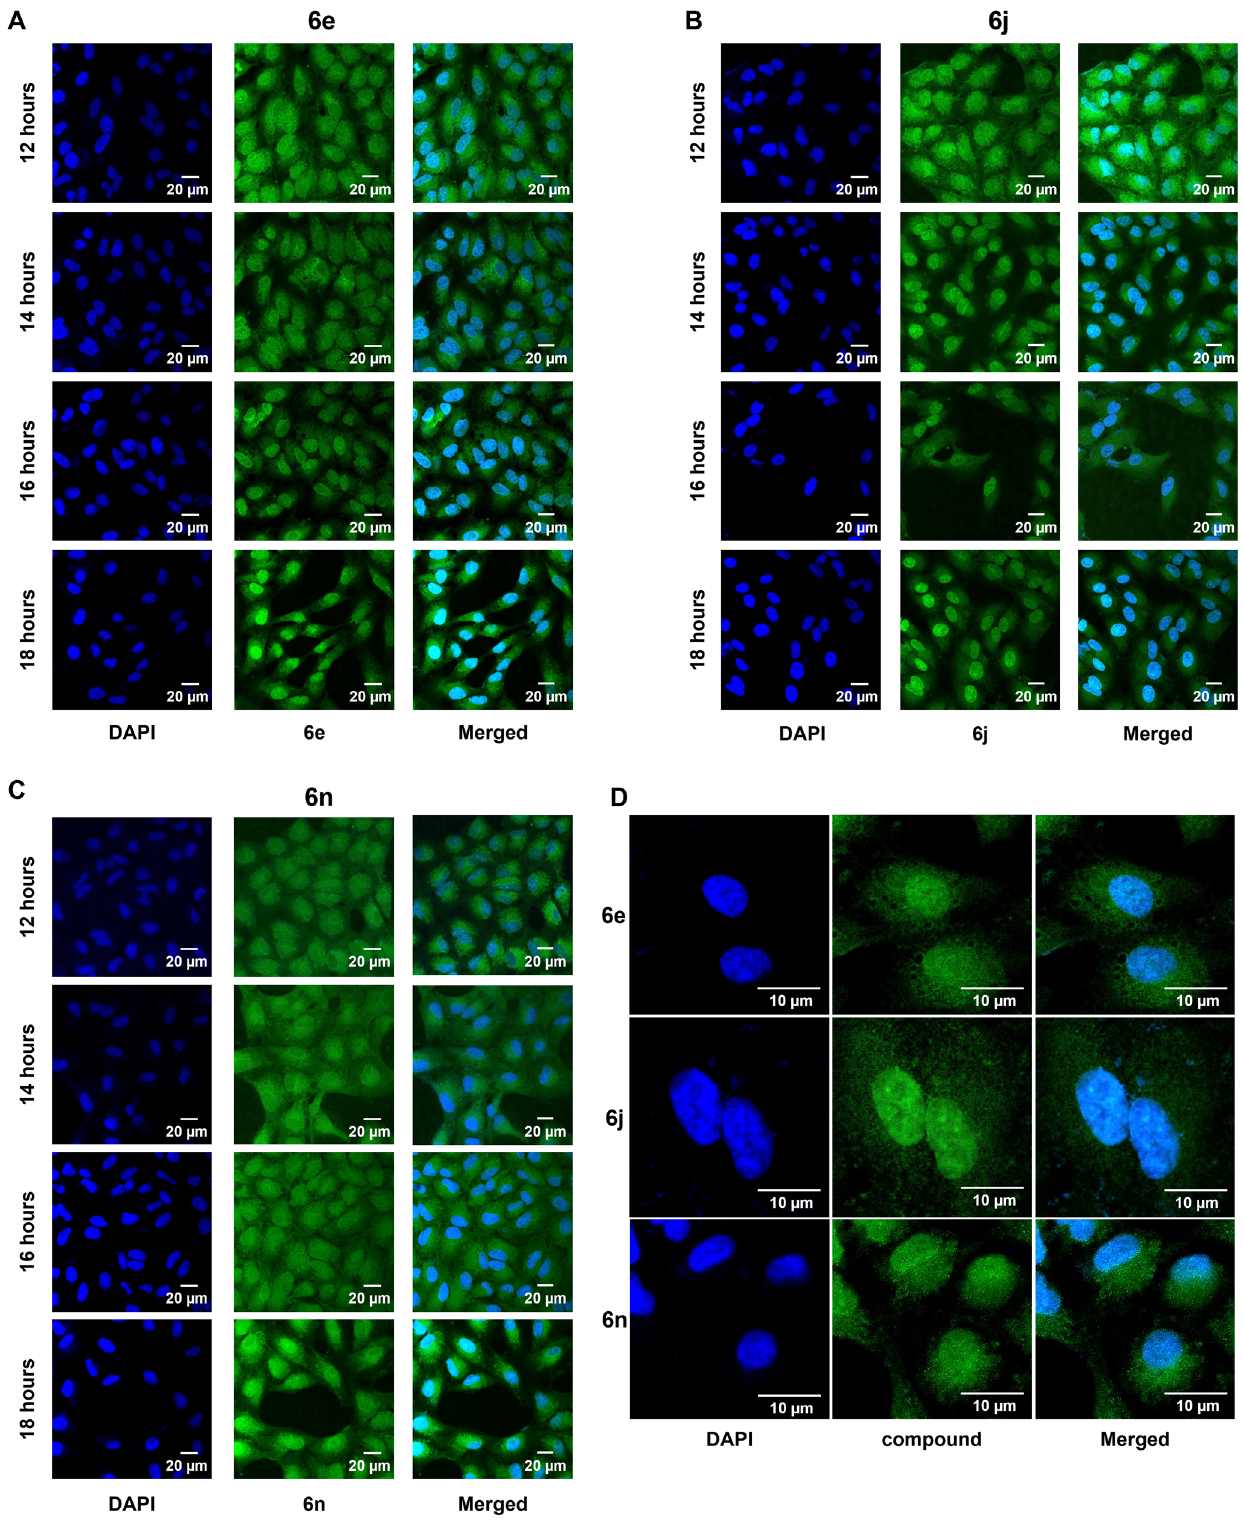
Fig. 6 Localization of cATC derivatives in cells. Confocal microscopy images of HeLa cells treated with 6e , 6j , and 6n , and DMSO for 12, 14, 16, and 18 h. A – C , Middle panel shows green fl uorescent signal for 6e ( A ), 6j ( B ), and 6n ( C ) in cytoplasm and nucleus at different time points. Left panel shows DAPI staining for nucleus. Right panel shows merged images. Scale bar is 20 μ m. D Middle panel shows images of HeLa cells at 60x fold magni fi cation for 6e, 6j , and 6n at 18 h. Left panel shows DAPI staining for nucleus. Right panel shows merged images. Scale bar is 10 μ